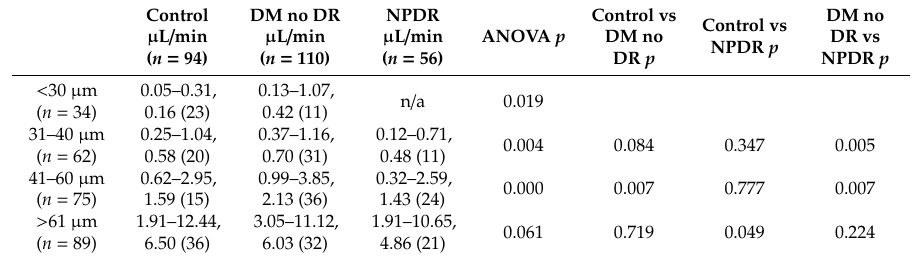
Figure 3. Log–log scale of blood flow in arterioles and venules by vessel diameter, comparing healthy controls, diabetes without retinopathy, and non-proliferative diabetic retinopathy. The exponent for blood flow as a function of diameter varied about a cubic relation depending on the patient group. Linear regression coefficients ( r ) were 0.991 for controls, 0.947 for DM without DR, and 0.969 for NPDR eyes. Abbreviations: DM = diabetes mellitus, DR = diabetic retinopathy, NPDR = non-proliferative diabetic retinopathy. Table 5. Summary of blood flow in arterioles and venules by vessel diameter groups, comparing healthy controls, diabetes without retinopathy, and non-proliferative diabetic retinopathy.